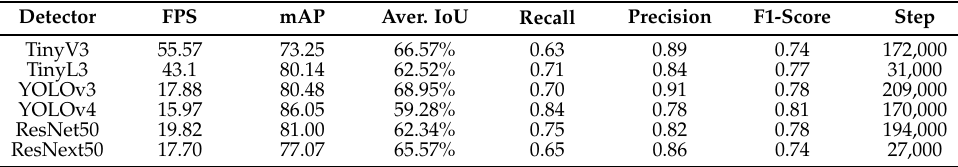
Table 2. Comparison of investigated detectors’ efficiency using different scores.